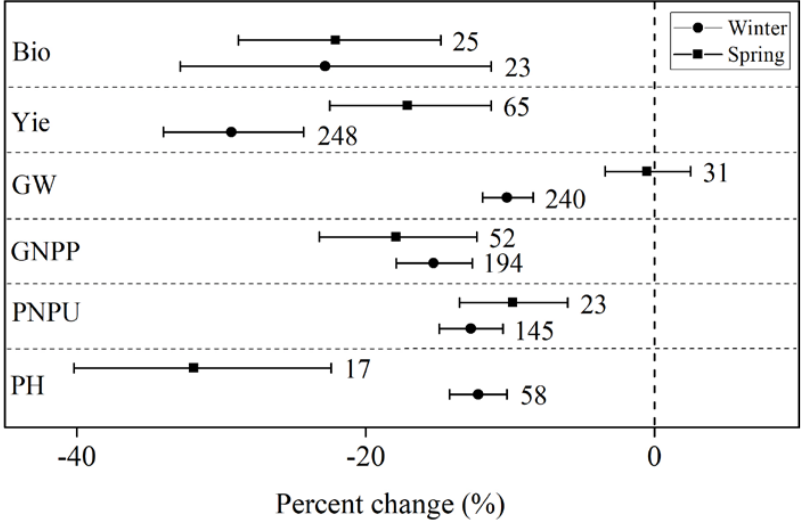
Figure 5. Effect of drought on winter and spring wheat. Numbers near the symbols specify the number of data points and the error bars indicate a 95% confidence interval. Abbreviations for the agronomic traits are described in Table 2.